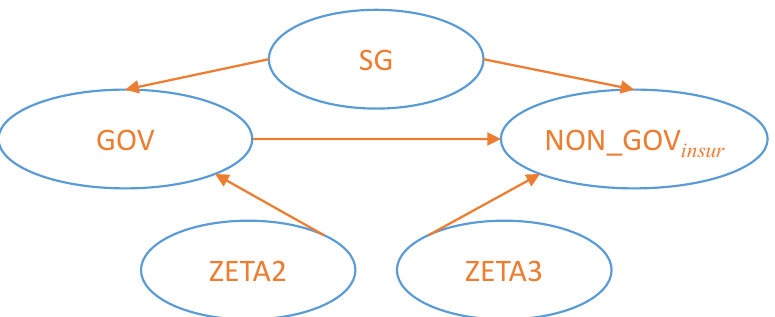
Figure 2. Regression relationships between latent variables for the first model, where ZETA1 and ZETA2 are the residuals